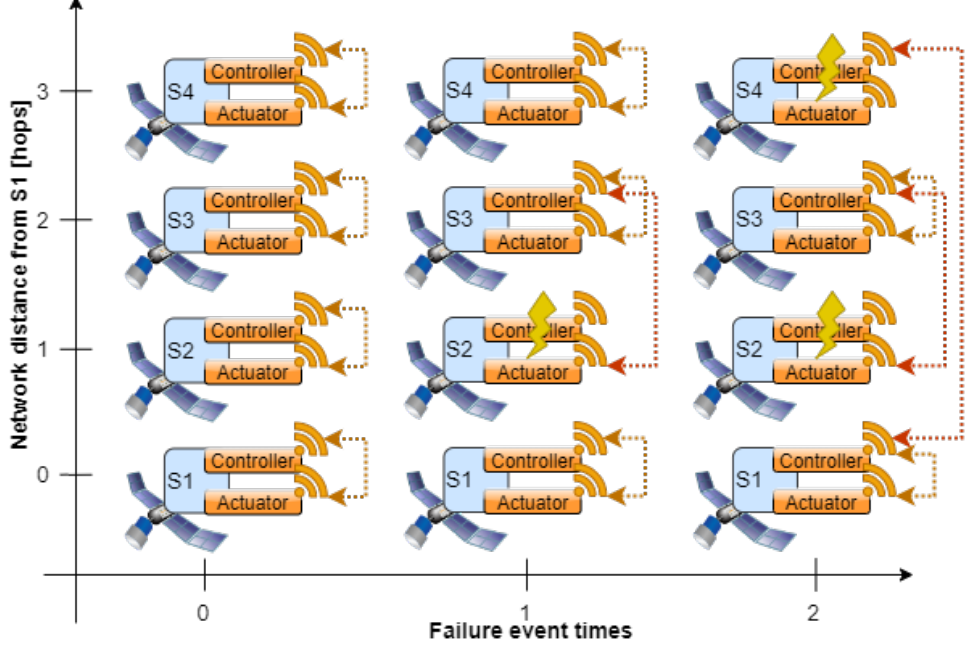
Figure 11. Suboptimal control task distribution with sequential-single-step allocation. The red dotted arrows represent the re-allocated control relationship. The last distribution could be optimized by having each of the satellites take care of the control task of its failed direct